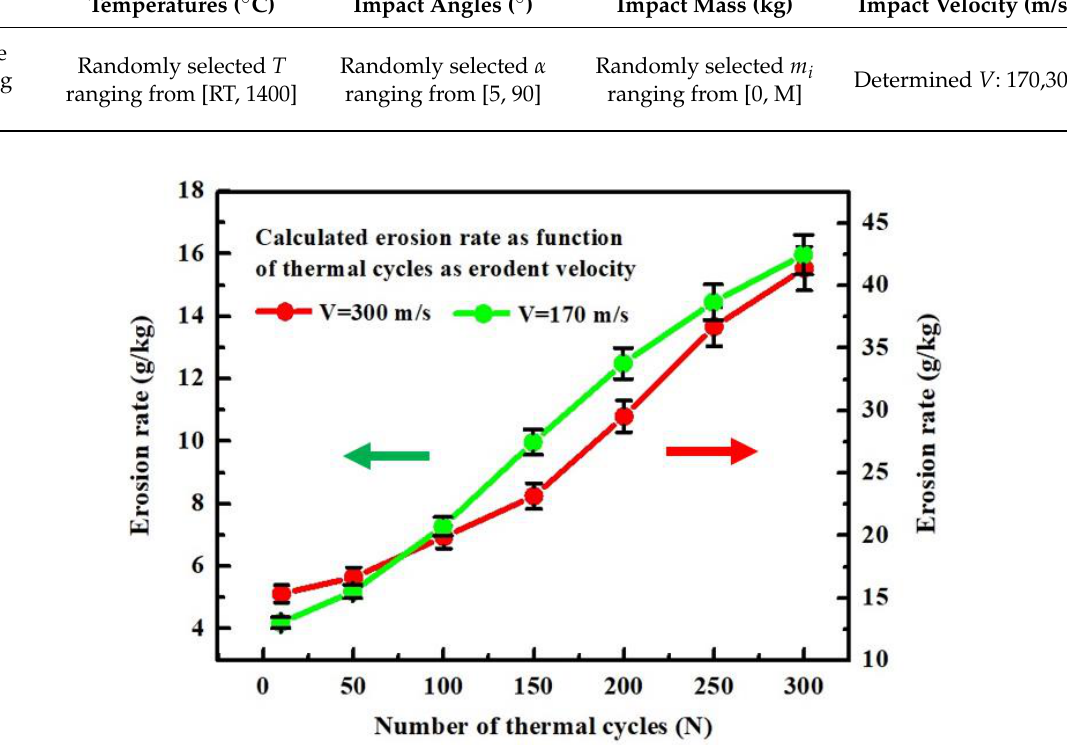
Figure 14. The calculated erosion rate versus thermal cycles at impact velocities V = 300 m/s and V = 170 m/s.